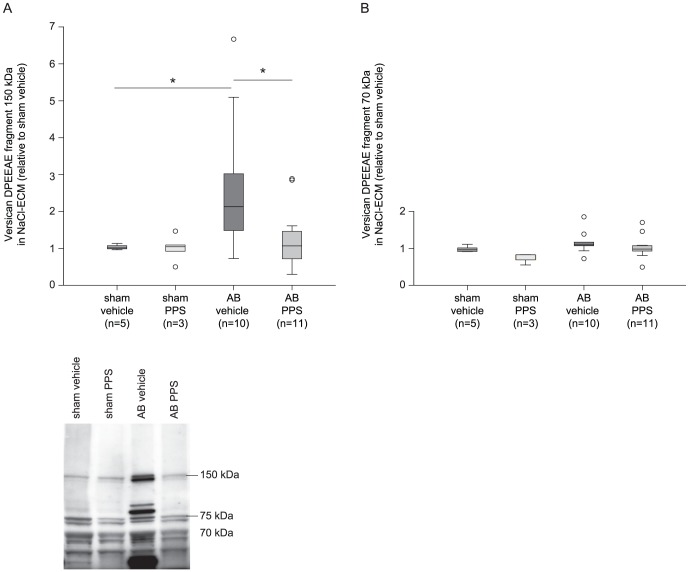
Versican p150 fragment level was reduced after PPS-treatment in rats with aortic banding.Myocardial levels of p150 (A) and p70 (B) versican DPEEAE fragment in NaCl-soluble ECM of rats subjected to AB with or without PPS-treatment, shown as representative immunoblot and box-plots with median (horizontal line), interquartile range (box), 1.5xinterquartile range or maximum/minimum range (whiskers) and outliers (>1.5xinterquartile range). *p<0.05. AB, aortic banding; PPS, pentosan polysulfate; ECM, extracellular matrix; HF, heart failure.